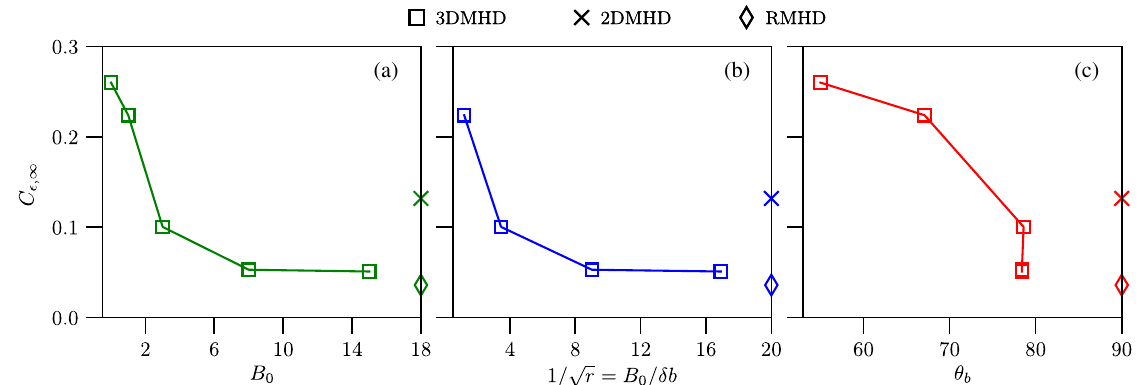
FIG. 2. Asymptotic value of the dimensionless dissipation rate C ϵ plotted against different measures of anisotropy. (a) C ϵ ; ∞ versus mean magnetic-field strength B 0 ; (b) C ϵ ; ∞ versus 1 = symbols represent results from the 3DMHD, RMHD, and 2DMHD runs, respectively. The RMHD and 2DMHD values are plotted at the edge of the horizontal